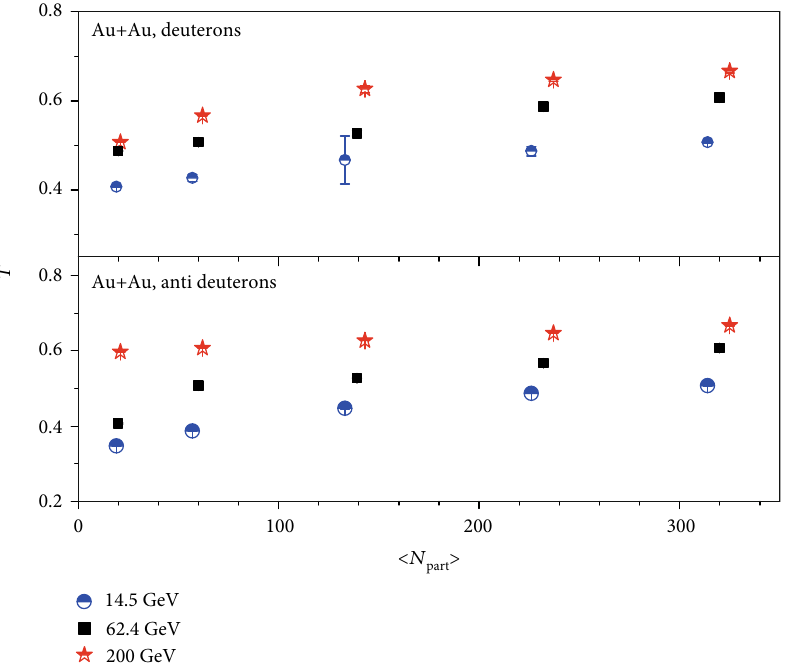
Figure 8: Dependence of T on the average number of participants for deuterons and antideuterons in events with di ff erent centrality intervals. The symbols represent the parameter values listed in Tables 2 –